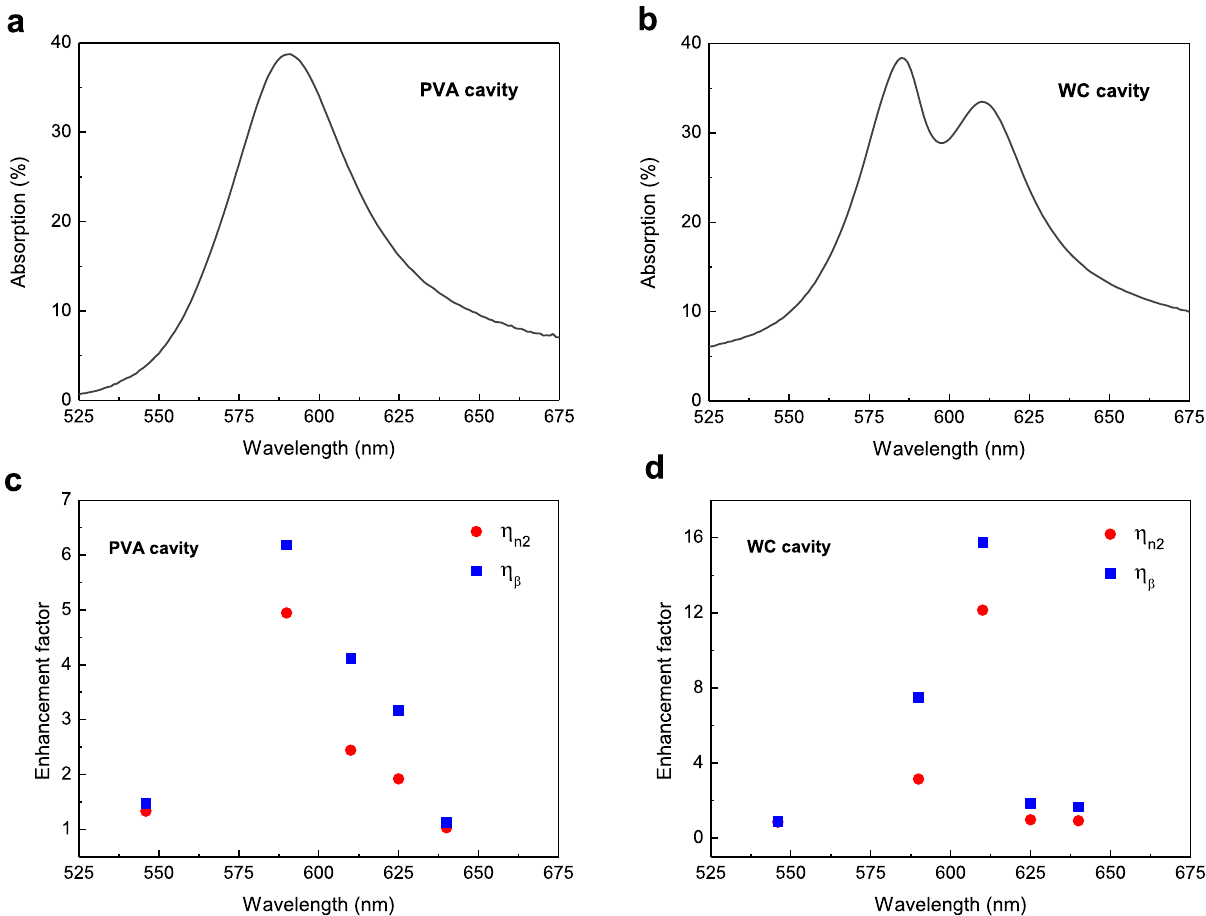
Fig. 3 Linear and nonlinear responses of the PVA cavity and weak-coupling system. Linear absorption spectrum of ( a ) PVA cavity and ( b ) WC cavity. c , d Are enhancement factors of n 2 (red circles) and β (blue squares) for PVA and WC cavities, respectively, at several representive wavelengths.